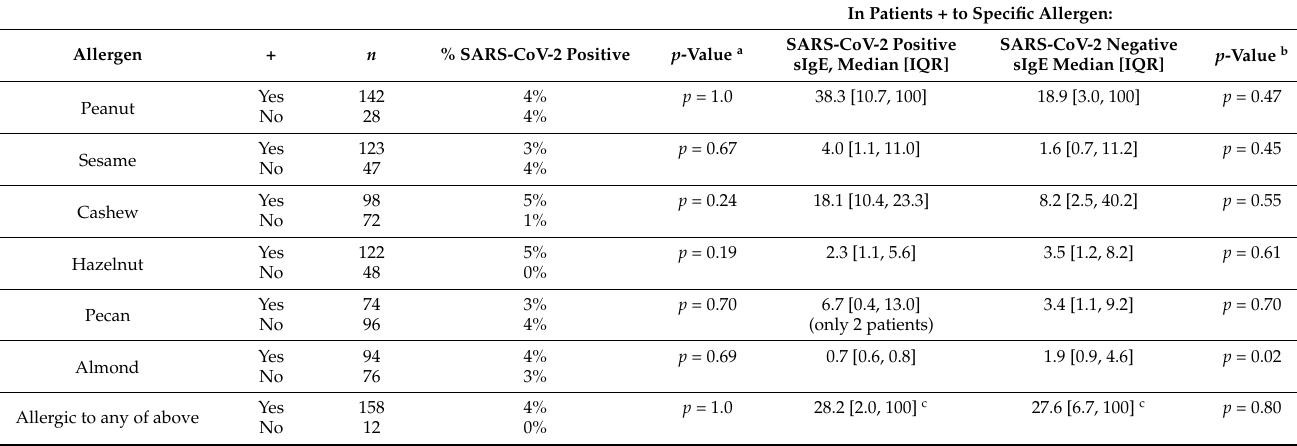
Table 3. Six common peanut and nut allergen parameters described in relation to positive SARS-CoV-2 status ( n = 170 with allergen test results).